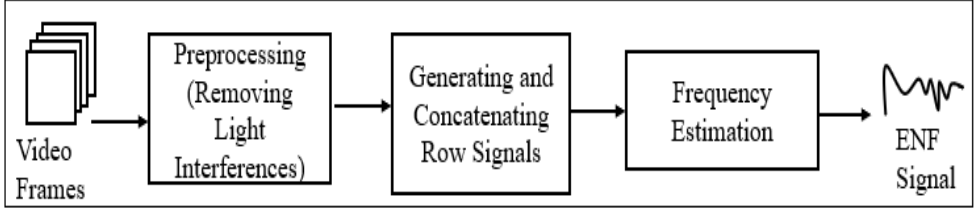
Figure 2. The process of ENF signal estimation from the frames of a video.